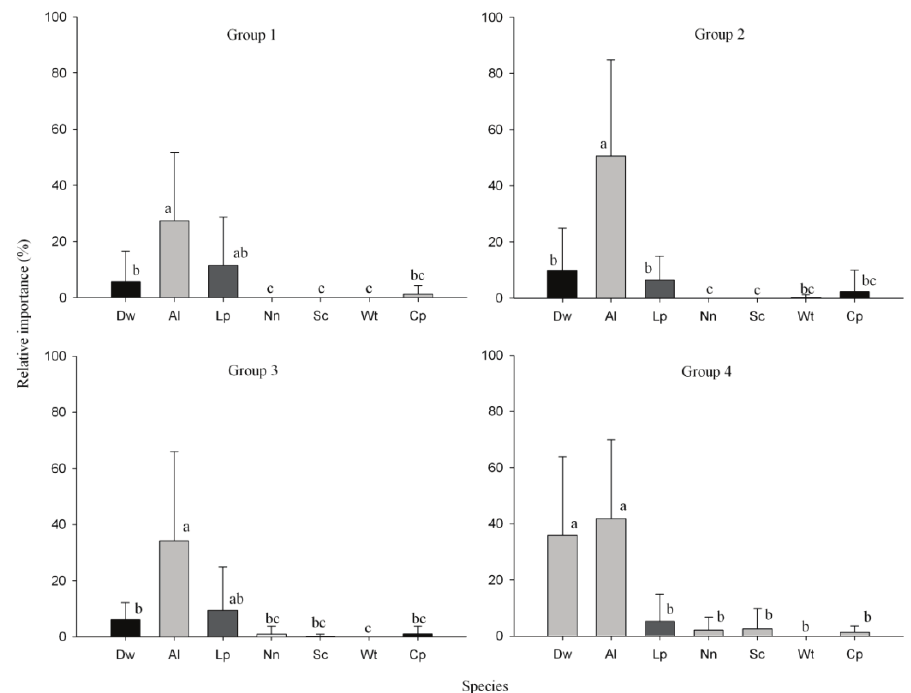
Figure 6. Relative importance values for the regeneration of each tree species by forest group. Abbreviations of species are given in Table 1. Different letters indicate significant differences ( P < 0.05) between tree